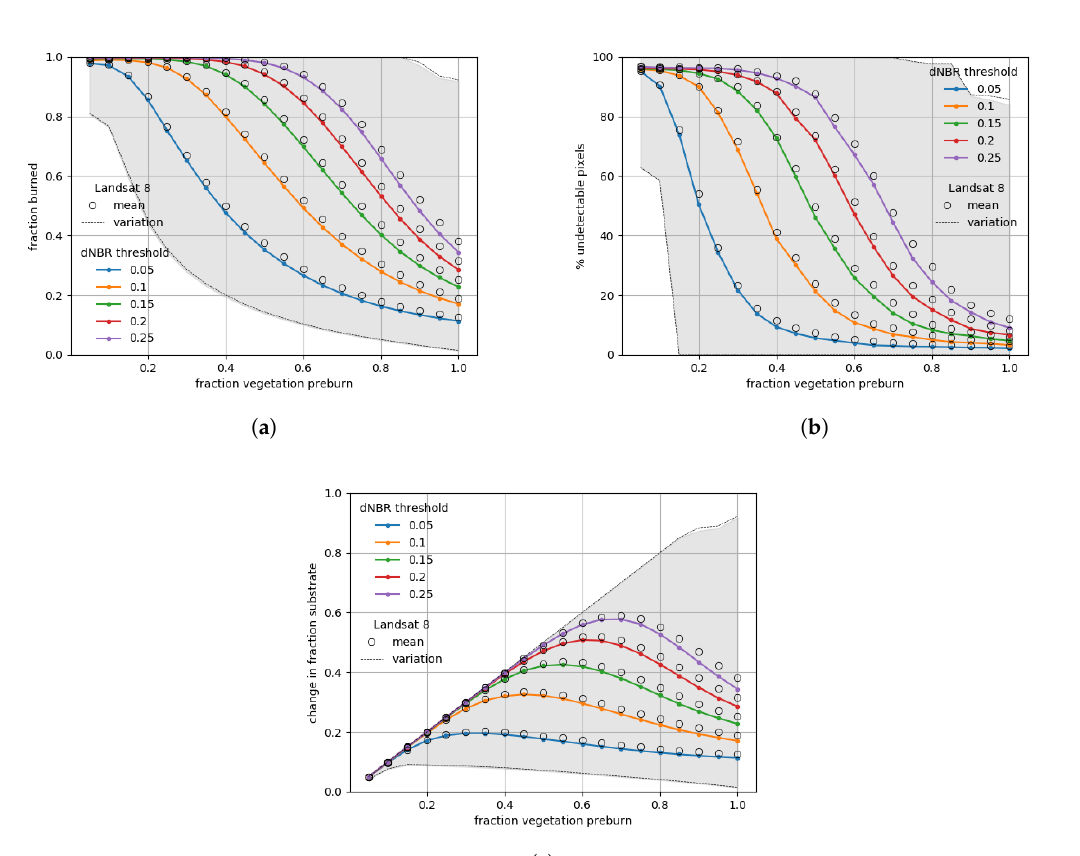
Figure A13. Park-wide detectability results for a vegetation removal scenario without fire ( ∆ char = 0), for the Moderate Resolution Imaging Spectroradiometer (MODIS). The mean values are shown in colored lines, with total model result variation shown in gray. To compare, the results for Landsat 8 are shown in black, with mean values shown by circles and total model result variation shown by dashed lines. ( a ) Fraction of vegetation burned at detection. ( b ) Percentage of undetectable pixels. ( c ) Increase in substrate fraction on detection.